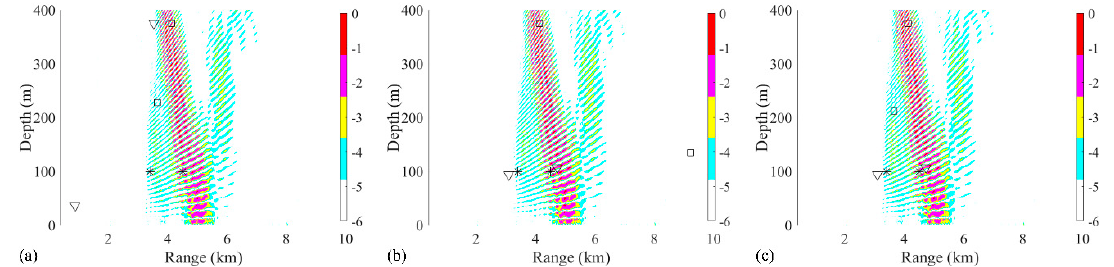
Figure 18. The ambiguity surfaces calculated by a Bartlett processor, the RAMP method, and the RAMPMF method with ( a ) 6; ( b ) 8 and ( c ) 10 snapshots. True source positions and the positions estimated by the RAMP and RAMPMF methods are represented as black asterisks, squares, and inverted triangles, respectively.